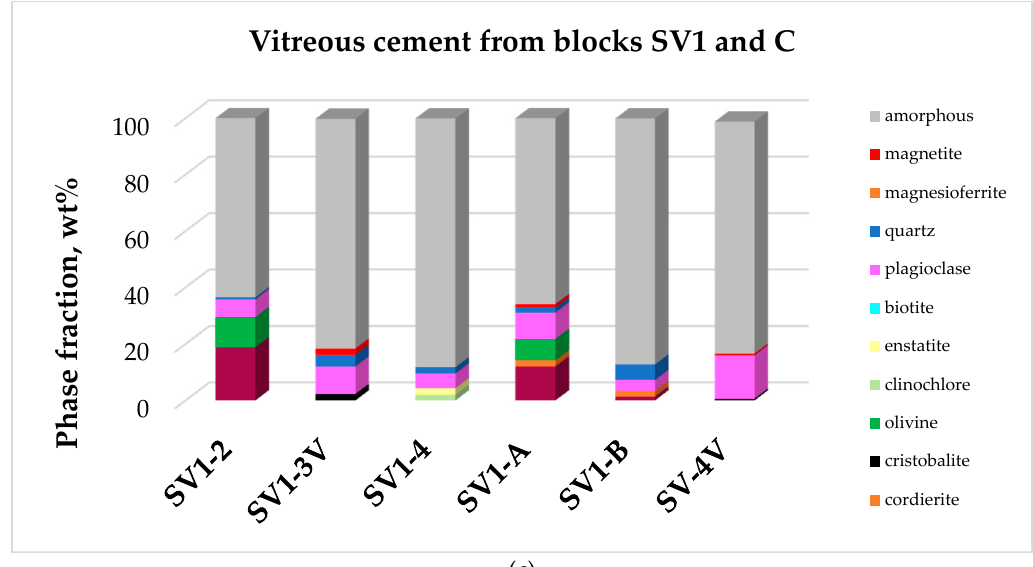
Figure 2. Quantitative mineralogy of the twenty five analyzed samples calculated via Rietveld method. ( a ) Relative abundances of main mineral phases (>1%) in substrate rocks; ( b ) Relative abundances of main mineral phases (>1%) in heated or partially vitrified rock fragments; ( c ) Relative abundances of main mineral phases (>1%) in vitreous cement from blocks SV1 and C.